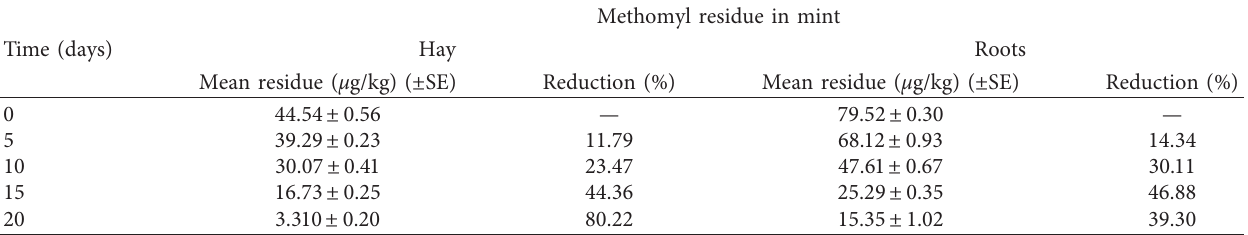
Table 1: Methomyl residues in mint cultured in the aquaponic system with known concentration (200 μ